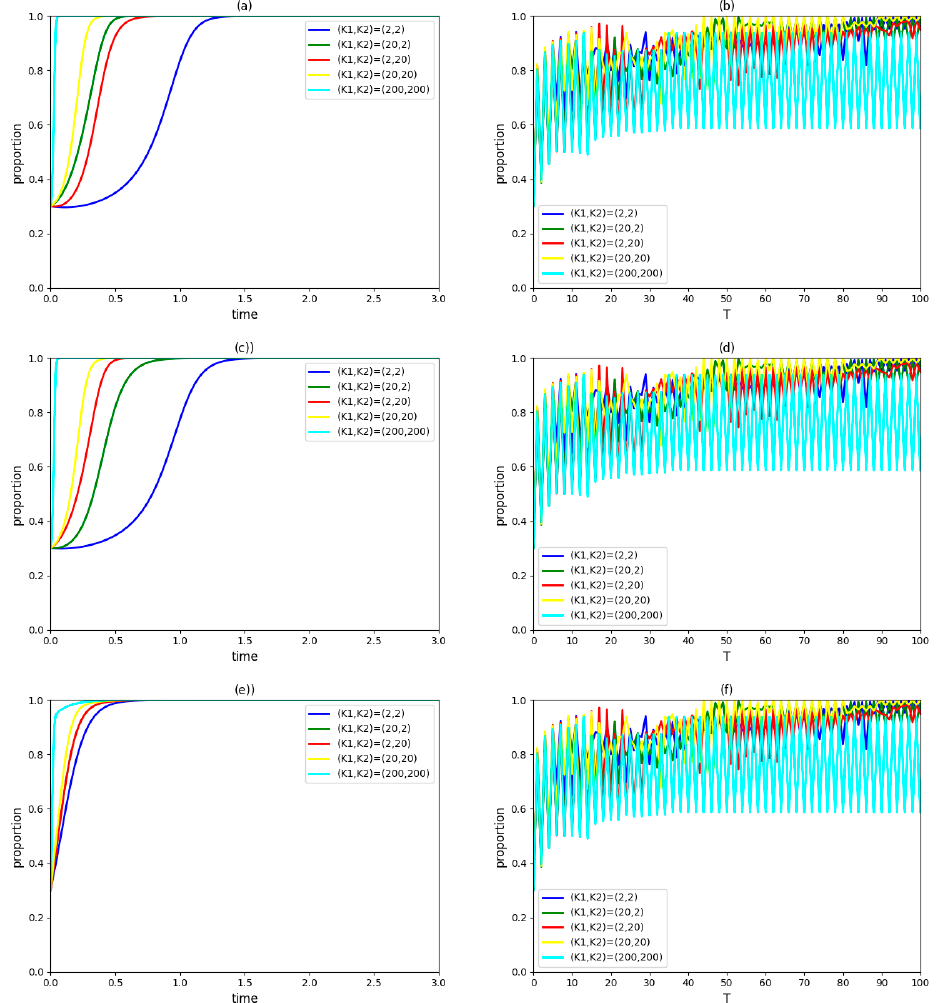
Figure 5. ( a ) The evolutionary paths of an enterprise strategies with different government penalties. ( b ) The proportion of cooperative enterprises in the region over time. ( c ) The evolutionary paths of university/institute strategies with different government penalties. ( d ) The proportion of cooperative universities/institutes in the region over time. ( e ) The evolutionary paths of government strategies with different government penalties. ( f ) The implementation of the proportion of the government adopting a participation strategy in the region over time.